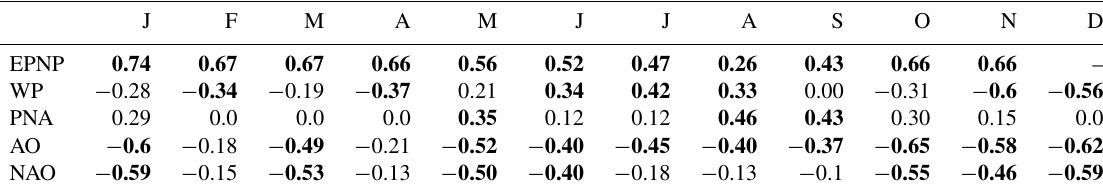
Table 3. Correlation between the dipole index and indices for five major climate modes of variability for the 1979–2013 period. Bold entries indicate 5% statistically significant correlation coefficients.